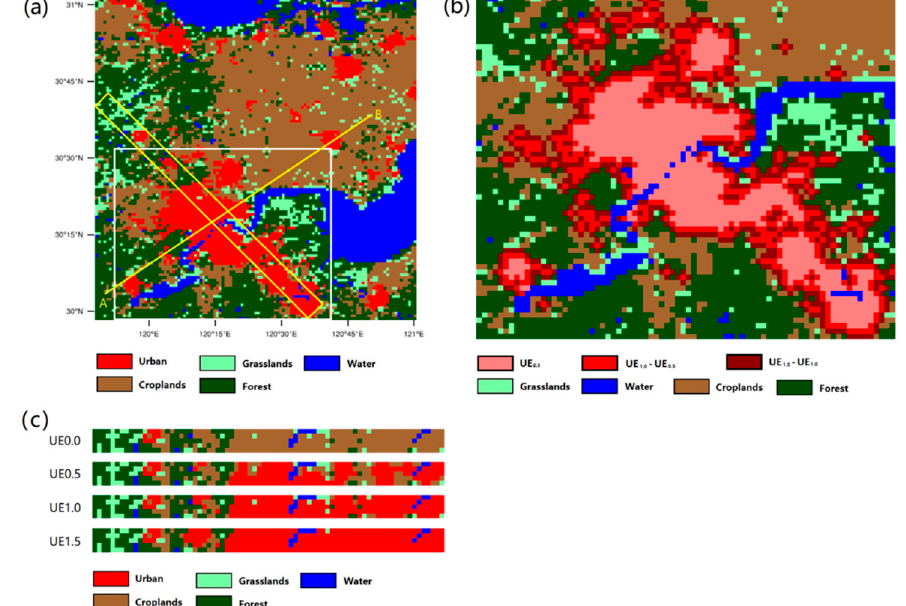
Figure 3. IGBP-modified MODIS 20-category land use [48] in ( a ) d03 (Figure 1a) with the location of the area modified in the four scenarios (Section 2.5) (white rectangle, detail in ( b )); cross-section analyzed (yellow rectangle, detail in ( c ) of modified urban extent); and the vertical cross-section (yellow line AB, see Figures 9 and 10); ( b ) modified (Section 2.5) land use; and ( c ) detail of area analyzed for the four scenarios (in Figures 6 and 11).